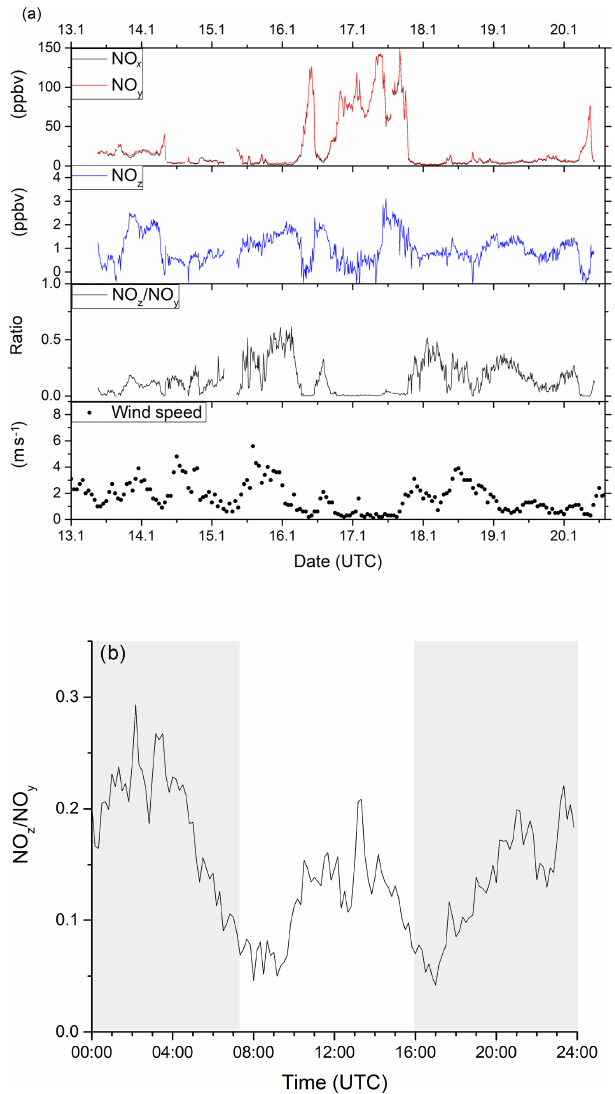
Figure 11. (a) Time series of NO x , NO y , NO z , NO z / NO y and wind speed from ambient measurements in Mainz, Germany, in January 2020. Highly variable NO x (between 0 and 150ppbv) and moderate NO z (between 0 and 3ppbv) mixing ratios were observed, identify- ing the sampled air masses as being dominated by anthropogenic emissions. Wind speed data was obtained from Agrarmeteorologie Rheinland-Pfalz (http://www.wetter.rlp.de, last access: 20 October 2020). (b) Diel profile of the NO z / NO y ratio including all mea- surement days, showing distinct minima during the morning and evening rush hours. Shaded areas signify the time between sunset and